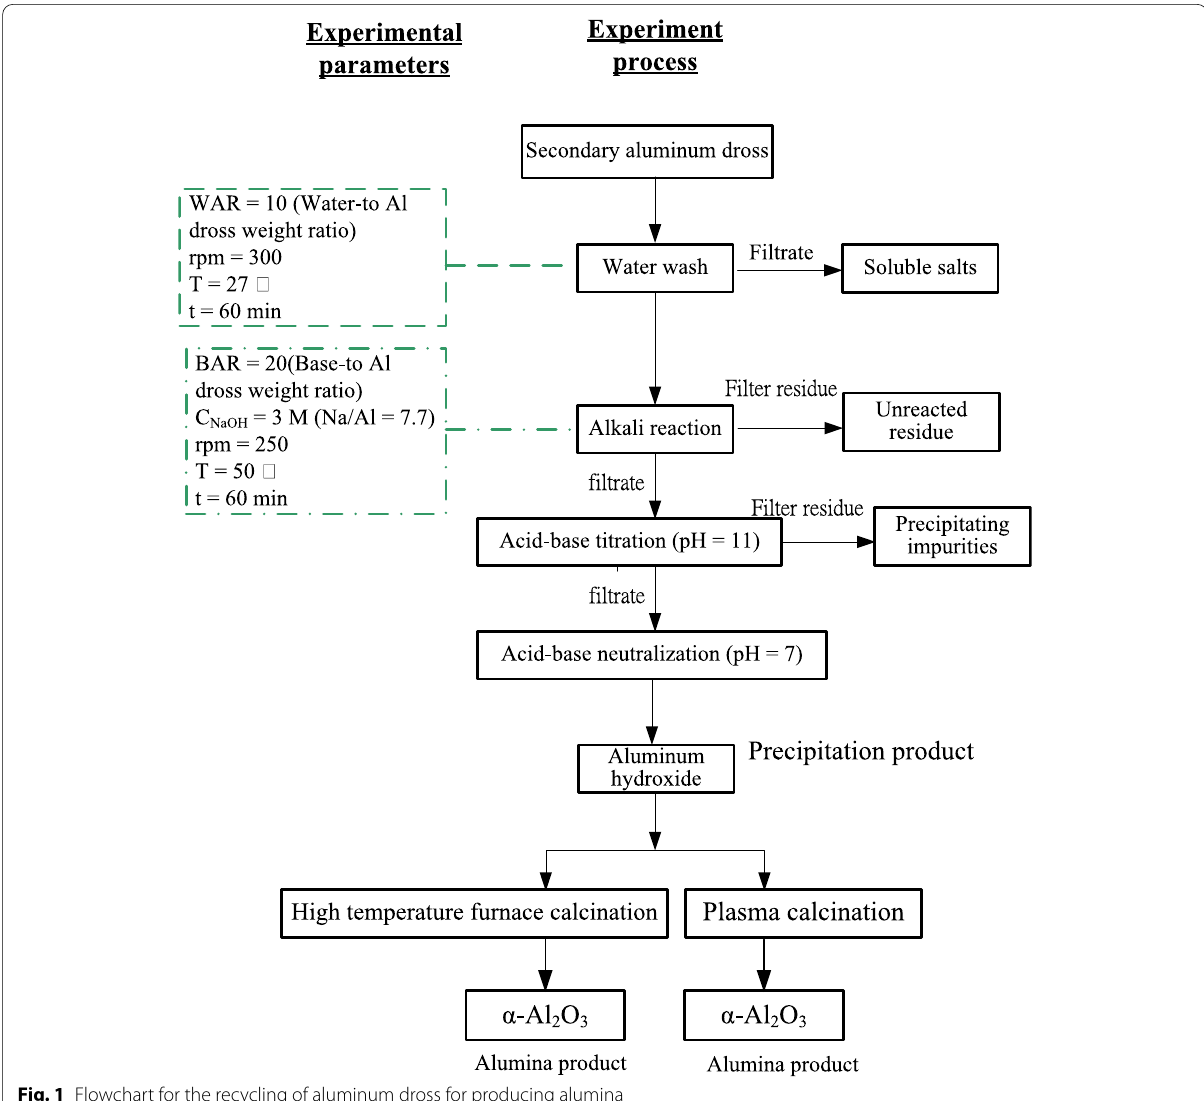
Fig. 1 Flowchart for the recycling of aluminum dross for producing